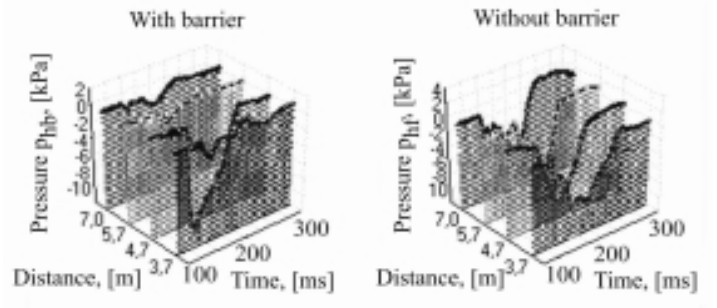
Fig. 21. Comparison of attenuated and unattenuated pressure trends vs. charge-structure distance at measurement depth of 0.10 m by gage No. 1 ( z/D =